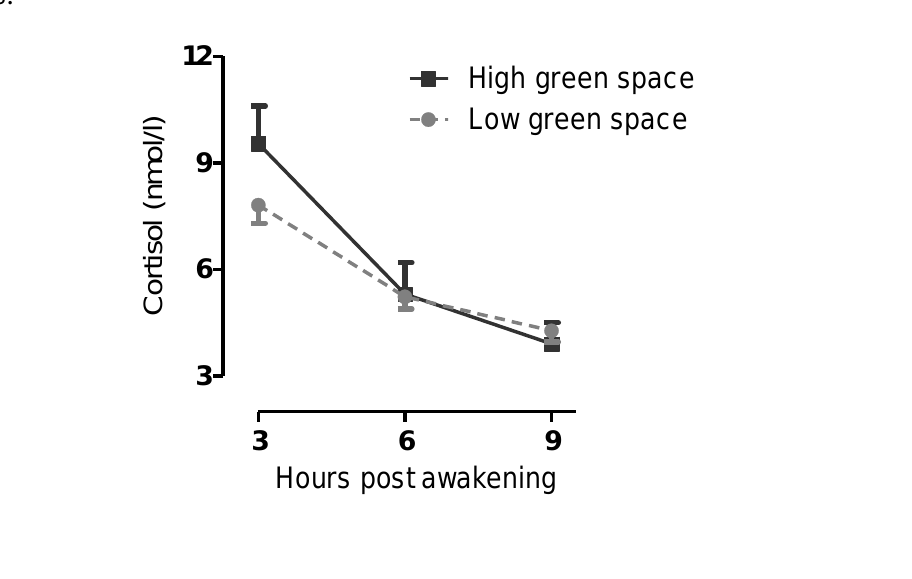
Figure 1. Difference in cortisol slope between participants living in high versus low green space